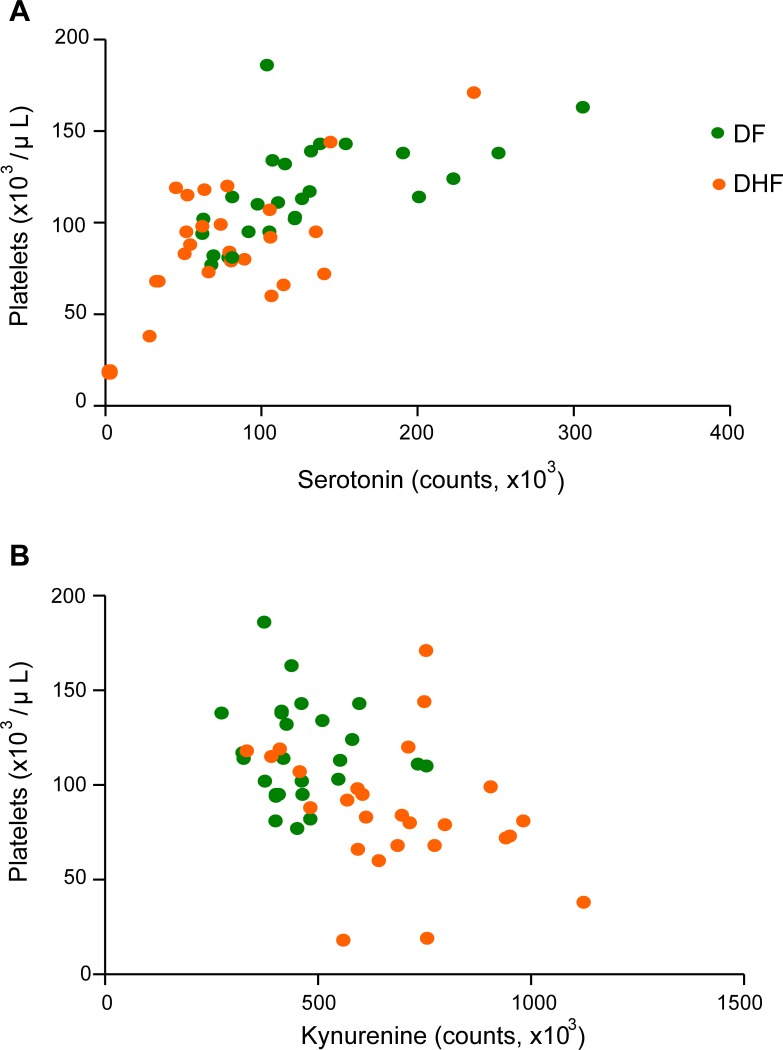
Pearson correlation analysis reveals correlation of platelets with serotonin and kynurenine in the febrile phase of infection.(A) Positive correlation between platelet and serotonin (r = 0.67; p<0.0001). (B) Negative correlation between platelet and kynurenine (r = ‒0.45; p<0.005). DF—dengue fever; DHF—dengue hemorrhagic fever.